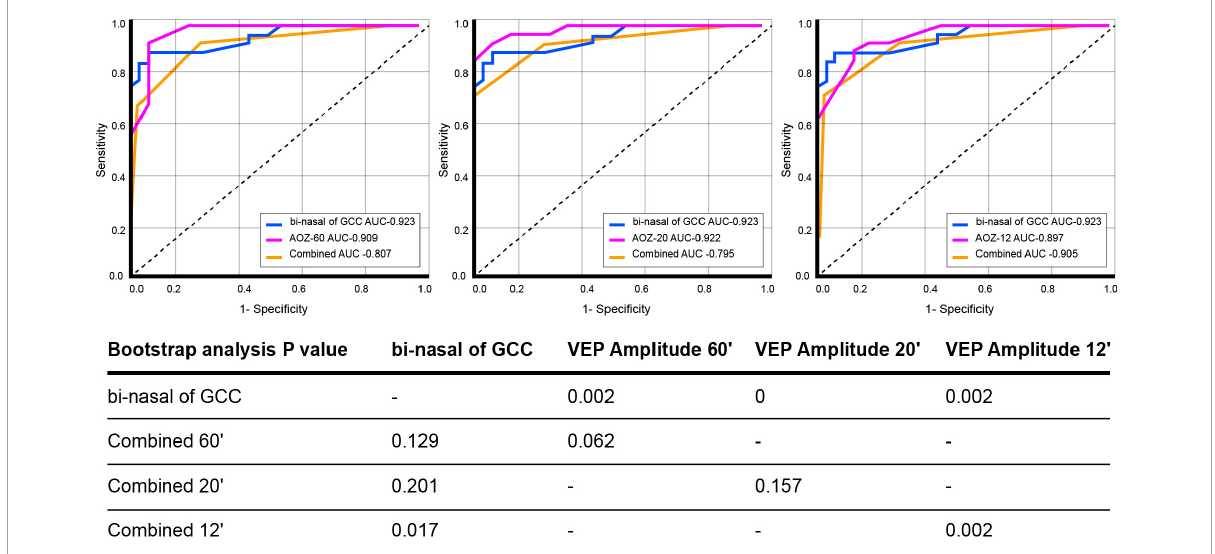
FIGURE2 ROC curves of pre-surgical visual evoked potential amplitude (Oz 60 (cid:48) , 20 (cid:48) , and 12 (cid:48) ), pre-surgical bi-nasal of ganglion cell complex, and combined. P related to bootstrap analysis with 10,000 iterations. Comparison between curves revealed that the bi-nasal of the ganglion cell complex is the most reliable biomarker for pituitary macroadenoma diagnosis. Visual evoked potential amplitude OZ at 60 (cid:48) and 20 (cid:48) , when optical coherence tomography evaluation with ganglion cell complex protocol is not possible, is the diagnosis biomarker of choice.